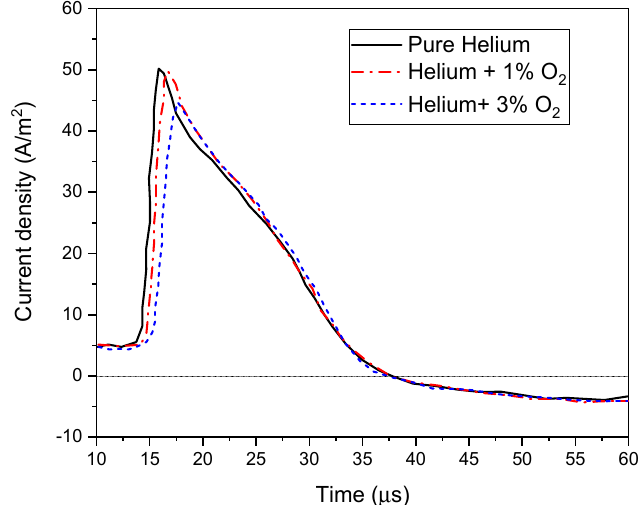
Figure 15. Current waveform distribution depending on oxygen addition at F = 10 kHz, V app = 30 kV.